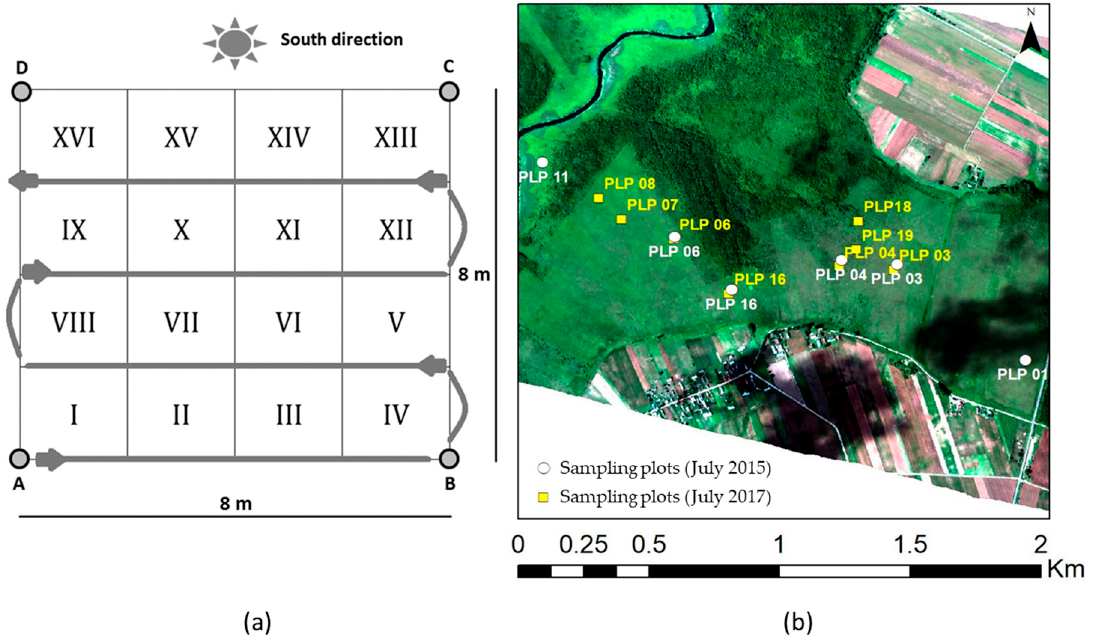
Figure 2. Measuring pattern of a single 8 × 8 m sampling plot ( a ) and their location in the Upper Biebrza valley ( b ).